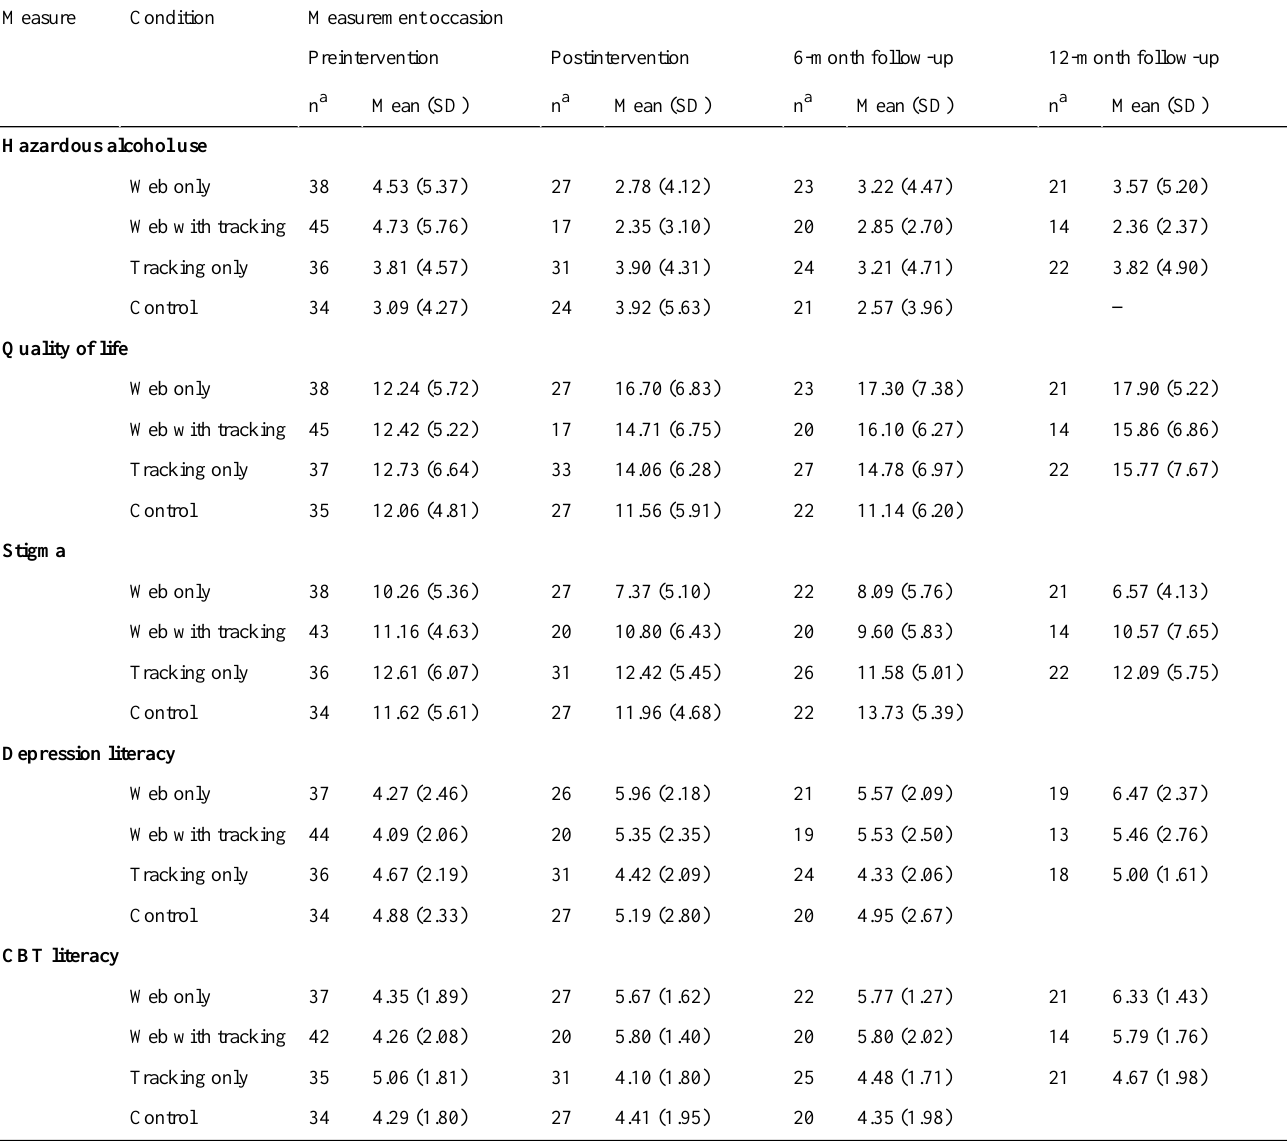
Table 1. Observed mean scores for hazardous alcohol use, quality of life, stigma, depression literacy, and cognitive behavioral therapy (CBT) literacy for each intervention condition across measurement